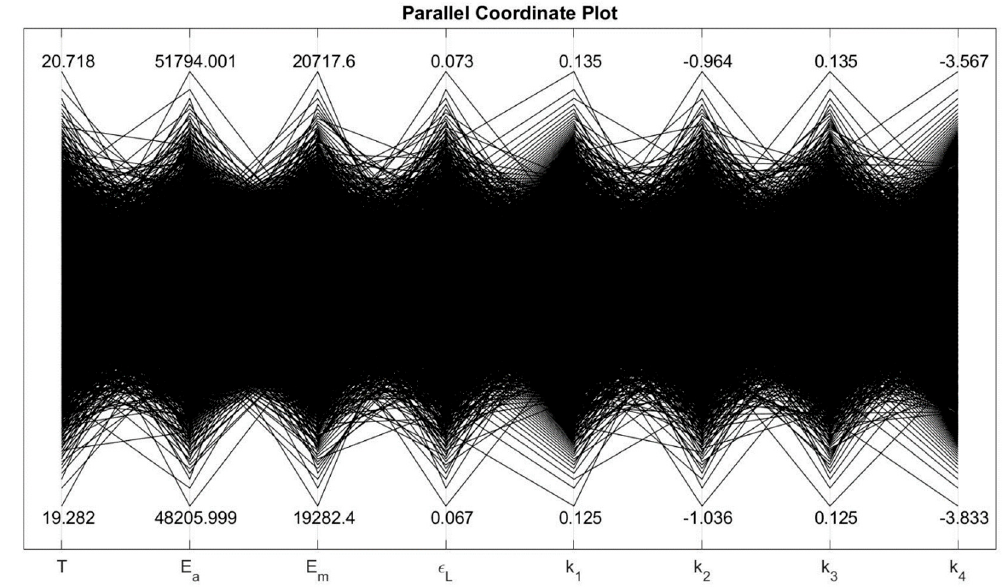
Figure 1. Parallel coordinate plot that shows upper and lower limits of input parameters at 20 °C.